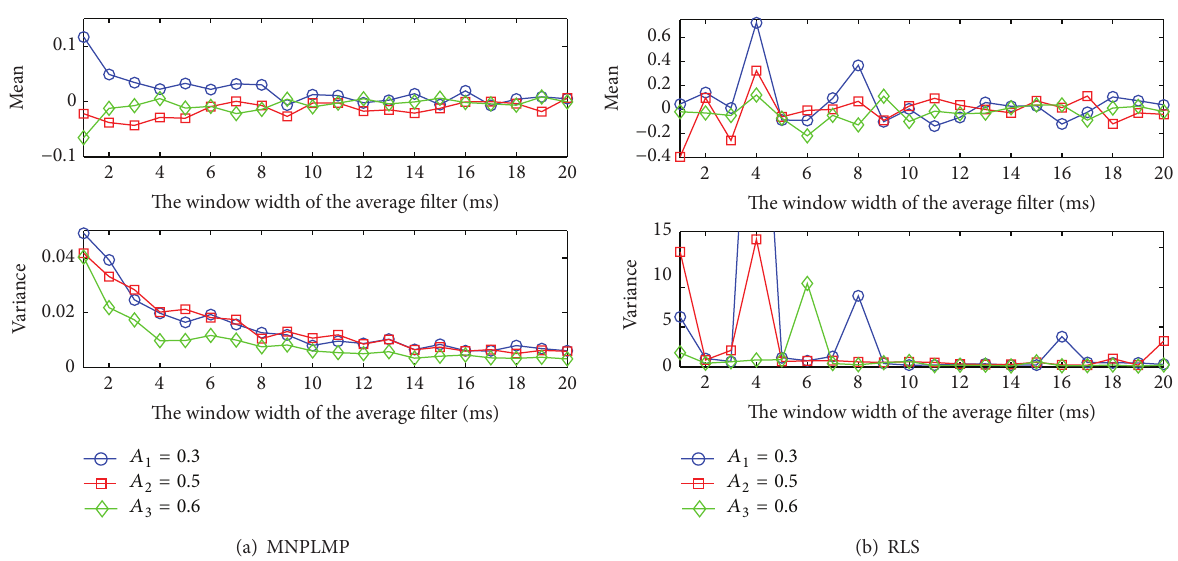
Figure 9: Multipath amplitude estimation error in various average filtering times under the impulsive noise environment.